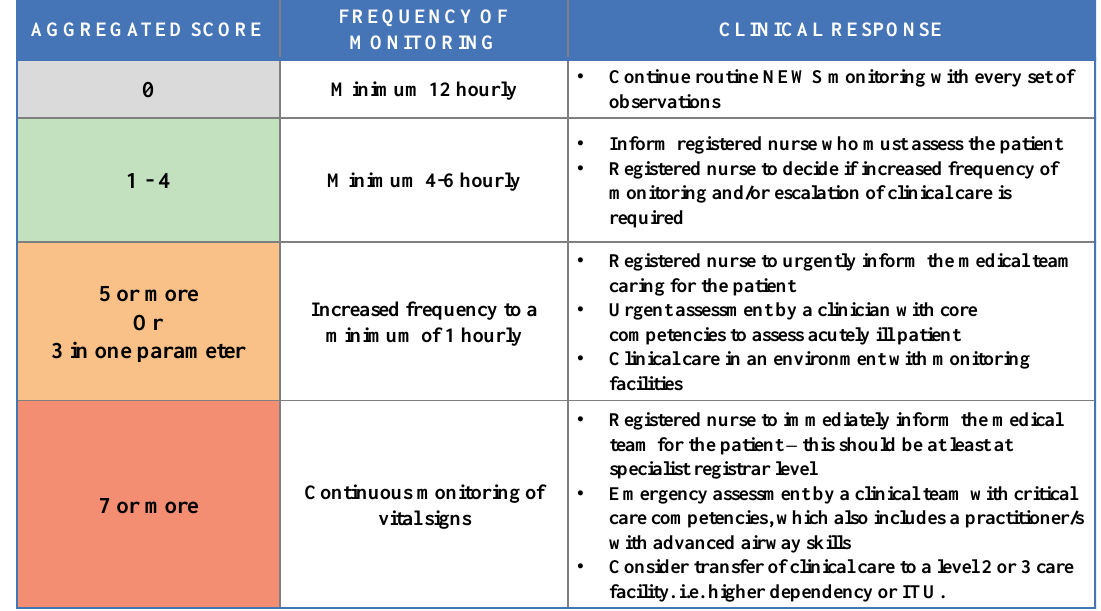
Figure 3. NEWS Clinical Response (NEWS-CR)